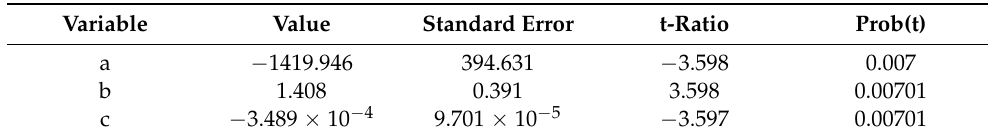
Table 9. Values of the coefficients of the mathematical model as a result of the regression for the considered data set.